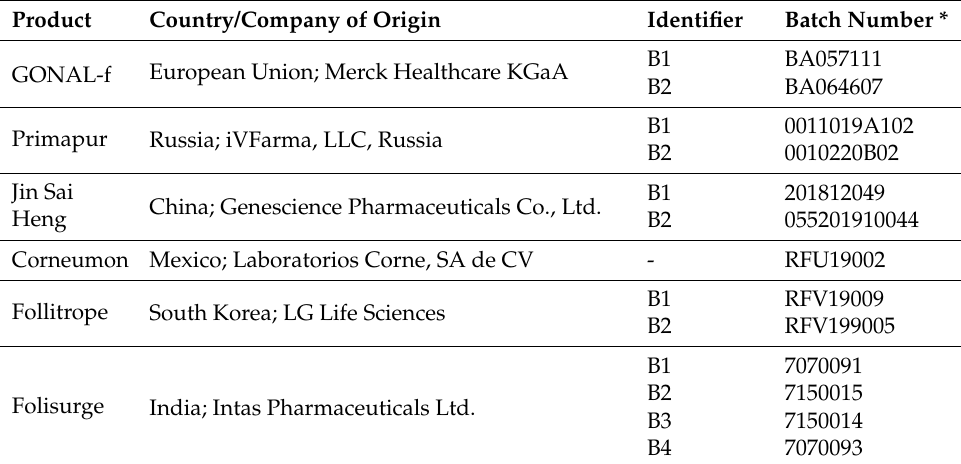
Table 1. Batches tested per preparation.